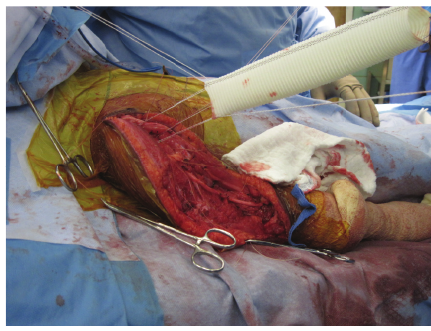
Figure 8: Vascular graft being positioned over glenoid prior to placement of endoprosthesis.